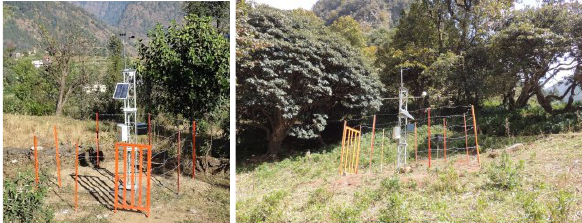
Figure 18. Installed AWSs at Guptkashi (Nov. 2016) and Dwali, Pindar valley (Oct. 2018), U.K.